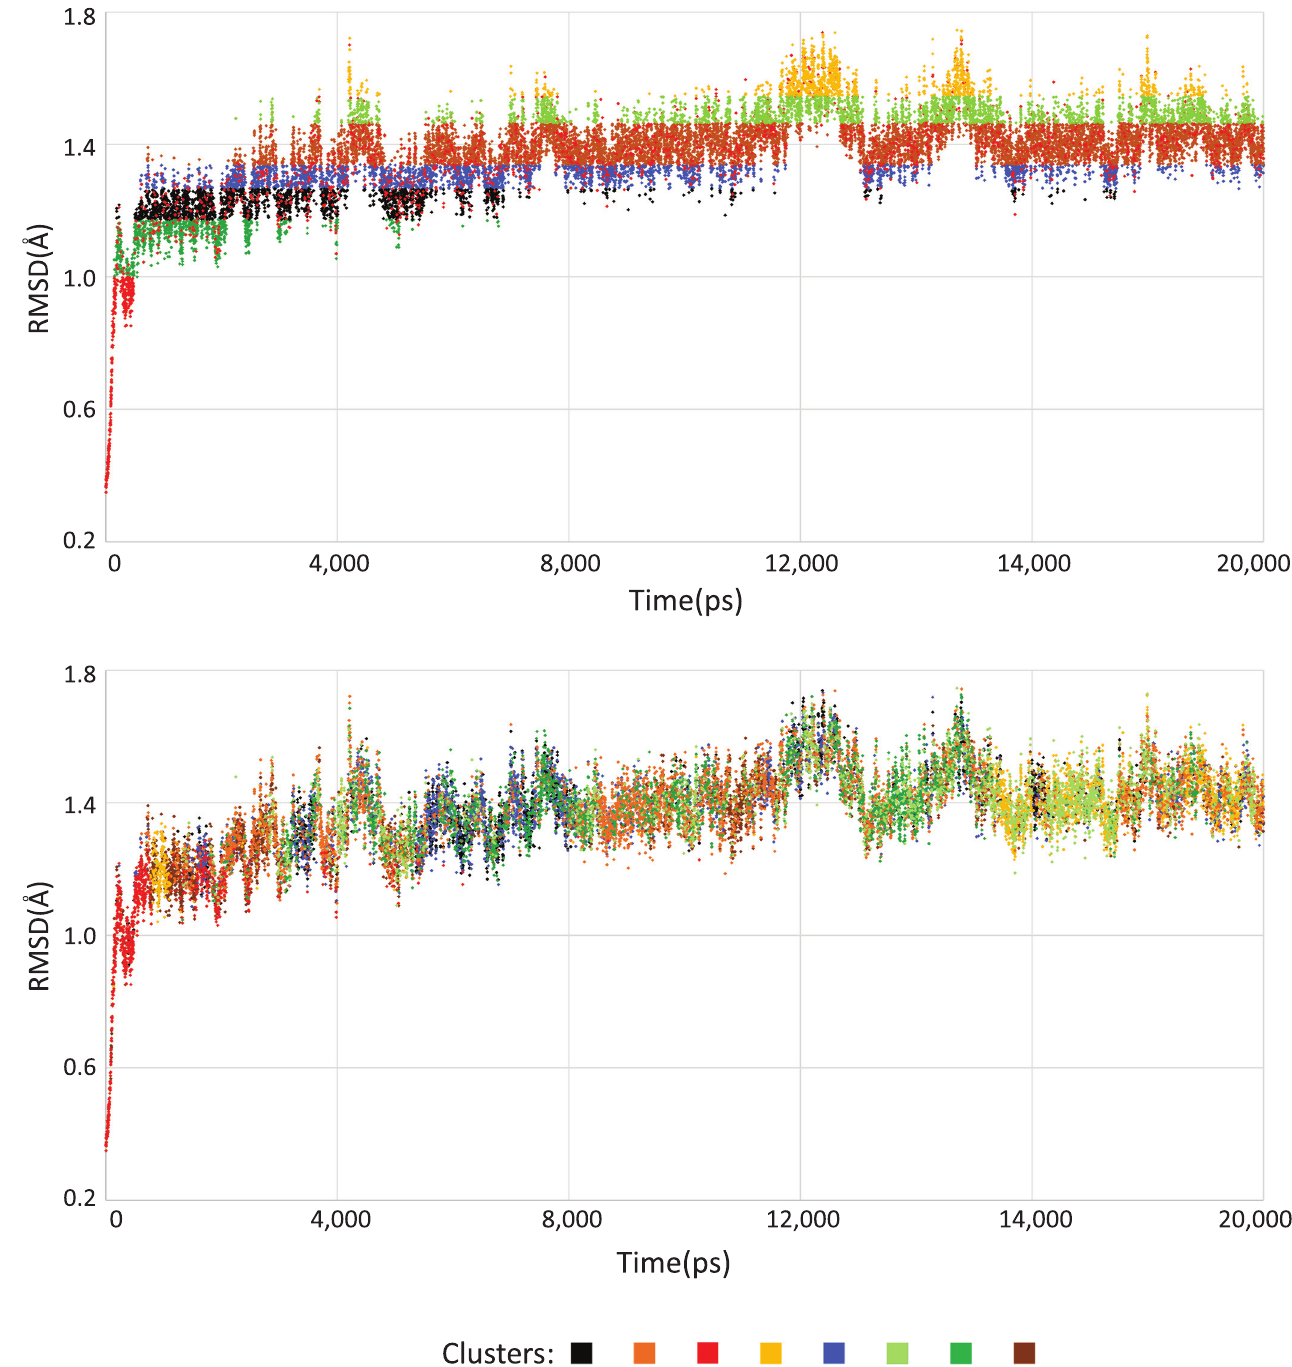
Fig 1. Comparisons of clustering results relative to two different measures of similarity for the InhA enzyme MD trajectory. In each case, the k - means clustering algorithm with the number of clusters of eight was used. The difference of the cluster dispersion between the traditional method and our methodology is evidenced by using the pairwise RMSD distance and the properties from the substrate-binding cavity in the scatter plots (a) and (b), respectively.